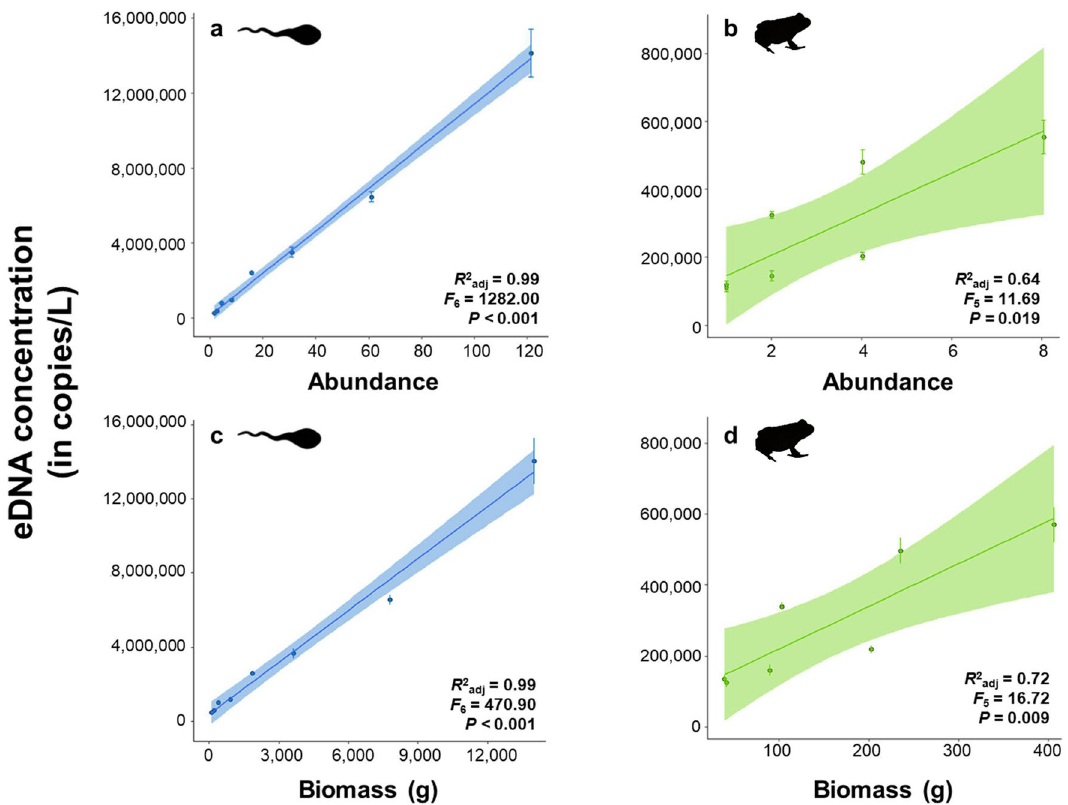
Figure 4. The relation between bullfrog eDNA concentration and abundance ( a , b ) and total biomass ( c , d ) of tadpoles (blue) and juveniles (green) stocked in the mesocosms, expressed as copies per liter filtered water. Dots represent the means of the technical replicates with the shaded areas around the regression line indicating the 95% confidence intervals. R 2 adj values, effect sizes, and P values of each regression are given in the bottom right corner of the corresponding graph.